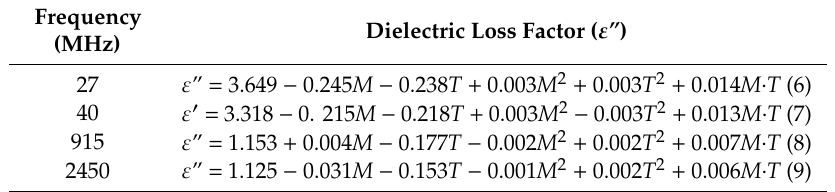
Table 4. Regression equations for the dielectric loss factors of the pecan kernels as functions of the